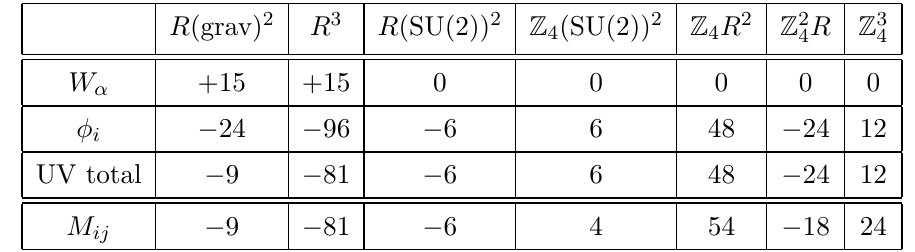
Table 11 . Anomalies between the UV and IR particle contents. The anomalies of continuous symmetries all match [24]. The Z anomalies are supposed to be matched mod 4, but they match 4 only mod 2, indicating the spontaneous breaking due to hOi .